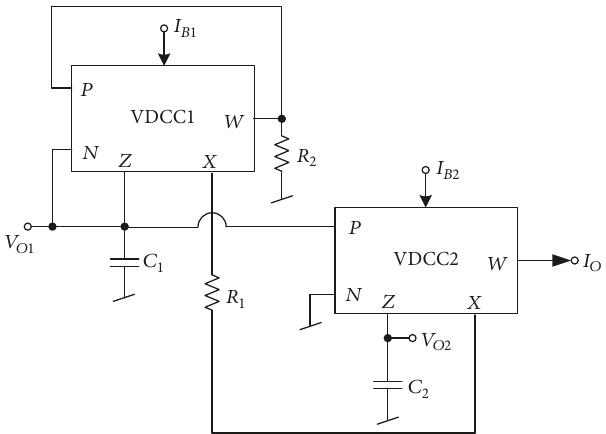
Figure 4: Proposed quadrature